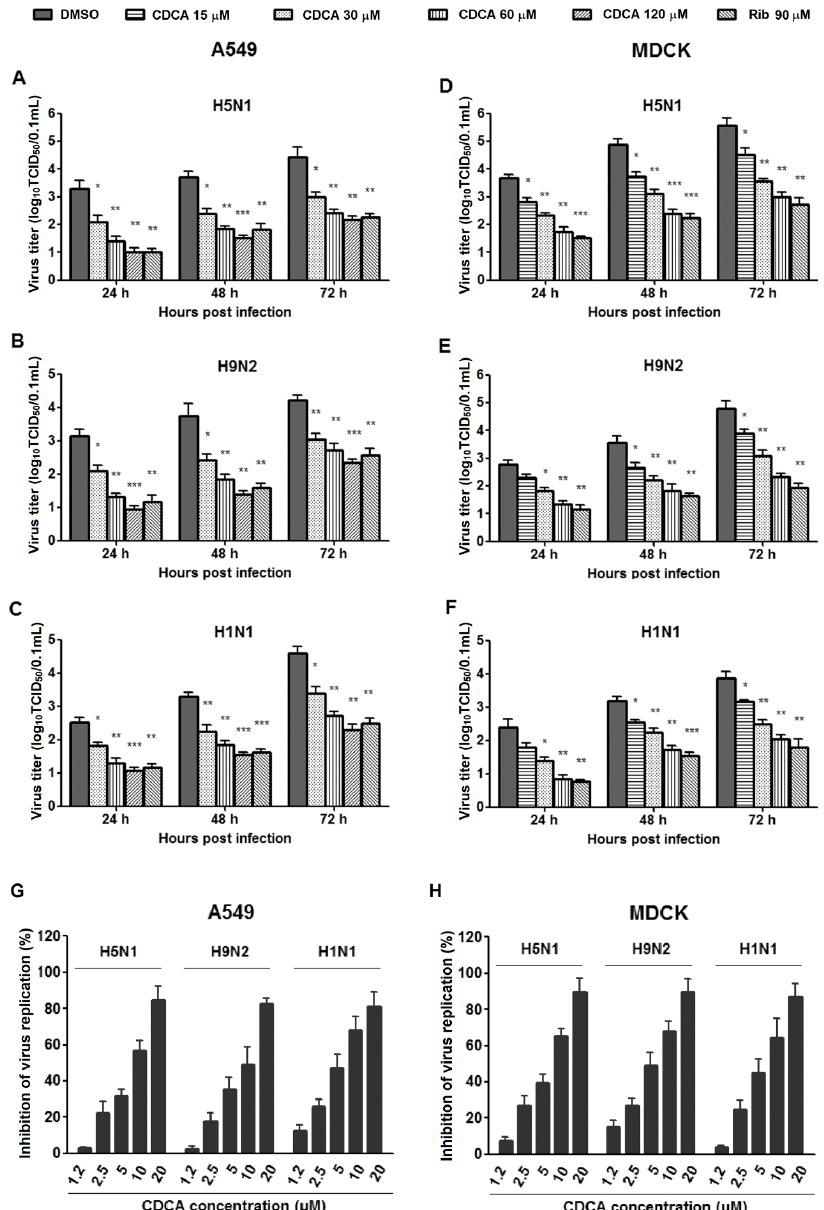
Figure 4. CDCA reduced progeny influenza A virus (IAV) yield in A549 and MDCK cell cultures. A549 or MDCK cells grown in 24-well plates were infected with influenza virus H5N1 (0.1 MOI) for 1 h, or H9N2 (0.5 MOI) or PR8 (H1N1) (0.5 MOI) for 2 h, respectively, and then cultured in fresh medium containing various concentrations of CDCA. At indicated timepoints postinfection, cells and supernatants were collected and subjected to viral titer determination using the end point dilution assay. Virus titer was expressed as log 10 TCID 50 /0.1mL. ( A , B , and C ) CDCA inhibited replication of H5N1, H9N2, and H1N1 viruses in A549 cell cultures, respectively. ( D , E , and F ) CDCA inhibited replication of H5N1, H9N2, and H1N1 viruses in MDCK cell cultures, respectively. Data are presented as mean ± SD of results from three independent experiments. * p < 0.05, ** p < 0.01 and *** p < 0.001 compared to the respective virus control (represented with DMSO). ( G , H ) CDCA reduced IAV